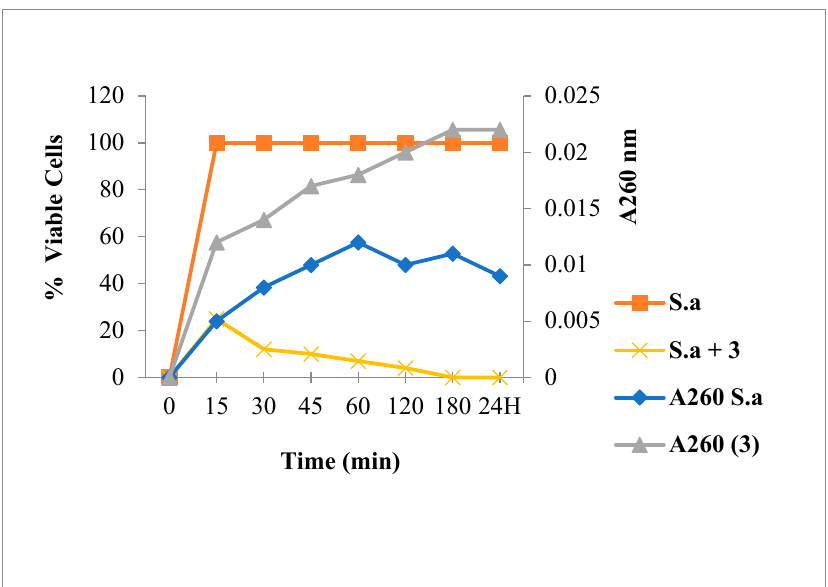
Figure 3. 260 nm absorbent material release and viability of S. aureus following Ampicillin ( Amp ) treatment.